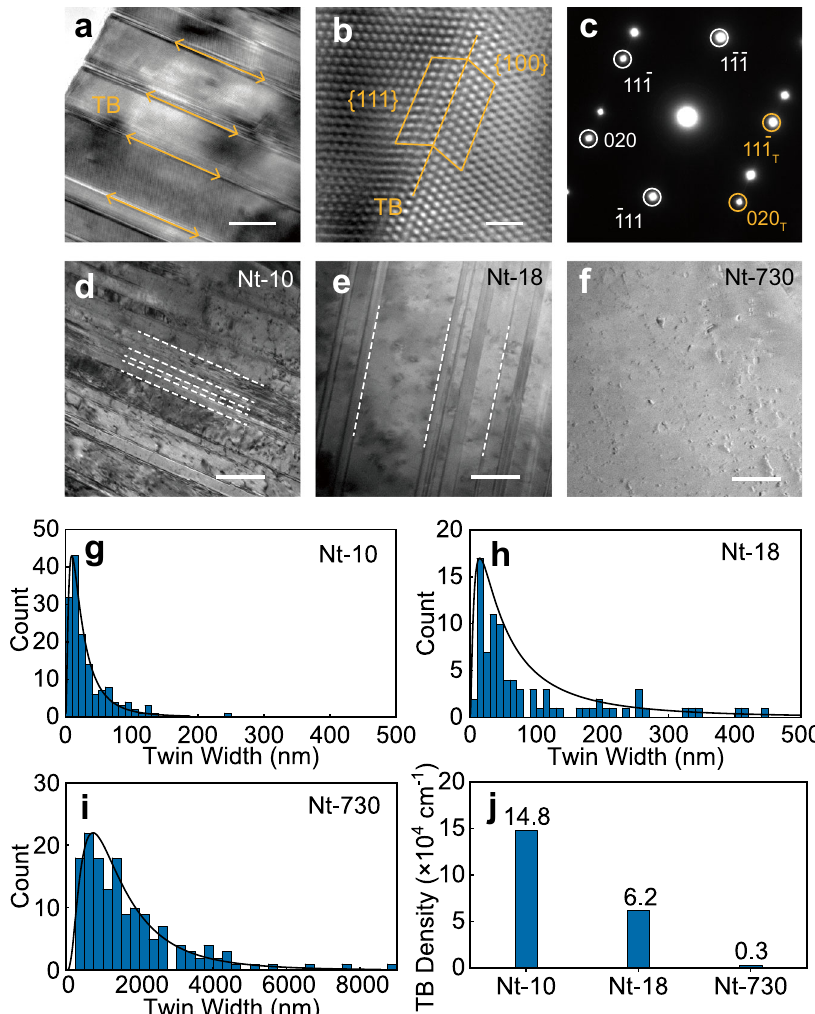
Fig. 1 Silver catalysts with tunable TB density. a TEM image of parallel TBs (scale bar: 10 nm). TB represents twin boundary. b The atomic arrangement of a representative TB in FFT-treated HR-TEM (scale bar: 1 nm). The two marked rhomboids represent the Burgers circuits. c The typical SAED pattern of silver ’ s TB. The white and yellow circles label diffraction spots of matrix and twin, respectively. d – f TEM images of Nt-10, Nt-18, and Nt-730, respectively (scale bar: 100 nm). The white dashed lines mark TBs. g – i The twin width distribution of Nt-10, Nt-18, and Nt-730, respectively. j The statistical histogram of TB